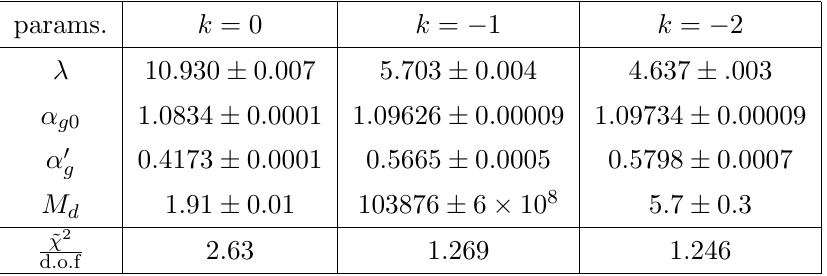
Table 2 . A table of (cid:12)tting results assuming the family of choices for (cid:31) discussed in section 3. d  ln dt ✓ ◆